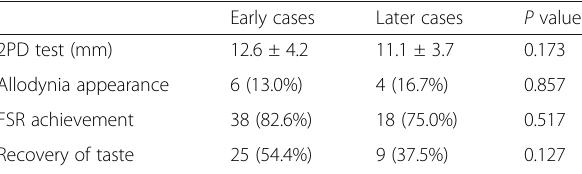
Table 4 Treatment period to improve sensory and taste function in early and later cases